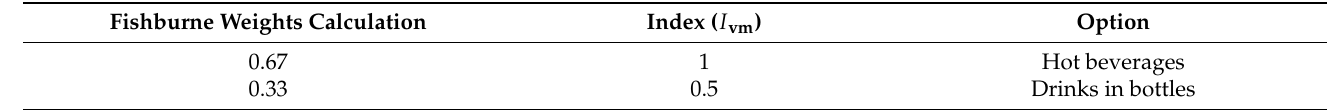
Table 12. Index system for vending machine option.